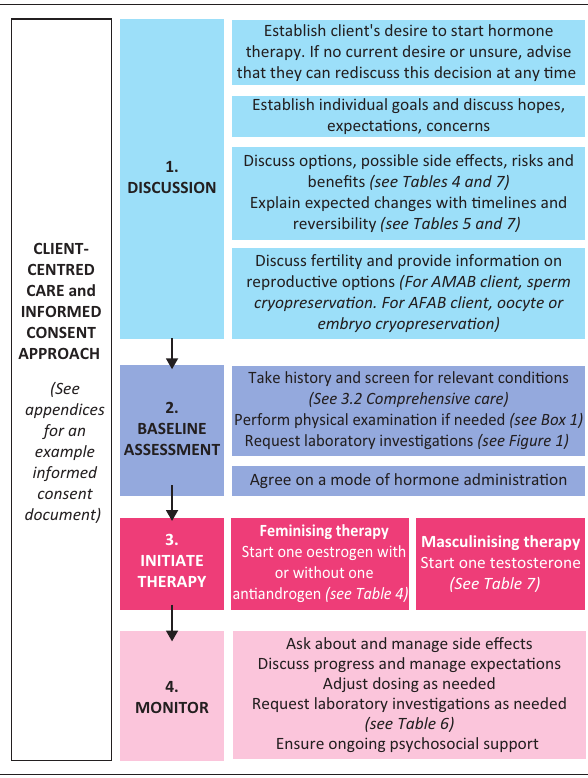
FIGURE 1: Recommended process for provision of hormone therapy.